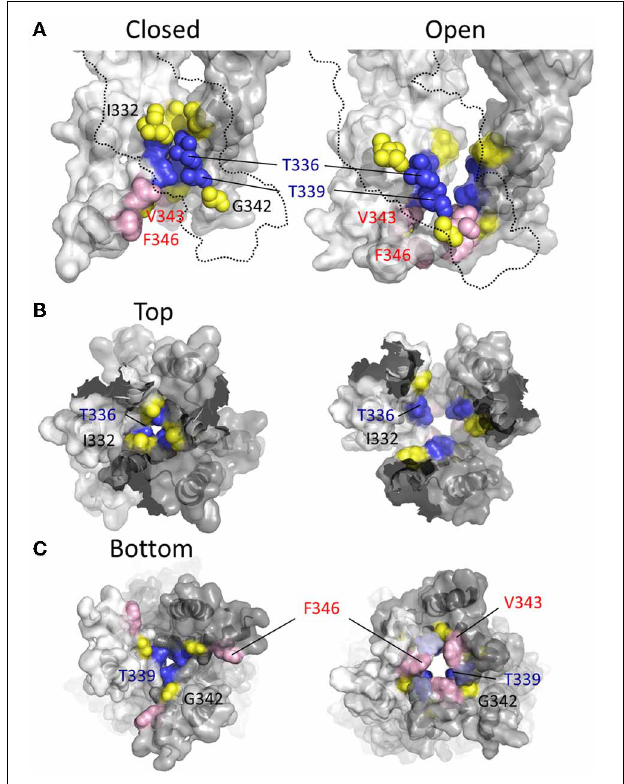
FIGURE 7 | Location of channel gate in P2X2R. (A) Side views of TM domains in closed (left panel) and open (right panel) conformation. Residues near and within the channel gate are shown in blue and yellow for all three subunits, with the remainder of the missing subunit outlined (dotted line). The blue residues highlight the putative channel gate. Residues immediately flanking this region are shown in yellow. Val 343 and Phe 346 , which converge upon the permeation pathway in the open state, are shown in pink. (B) TM domains viewed from the extracellular vestibule in the closed and open configurations. (C) TM domains viewed from the intracellular side in the closed and open